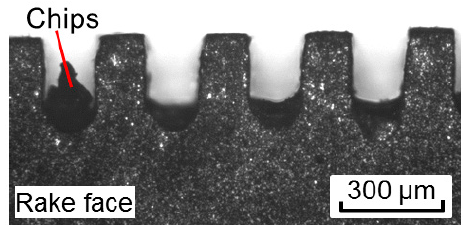
Figure 8. Used tool cutting edge after the experiment.